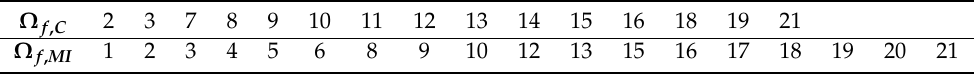
Table 3. Final feature set Ω f for the two ranking